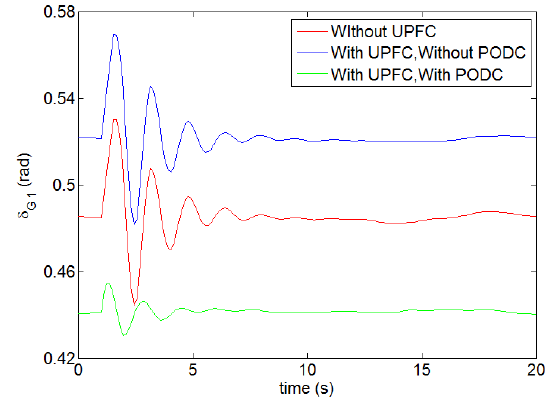
Figure 7. Power angle curves of G 1 .